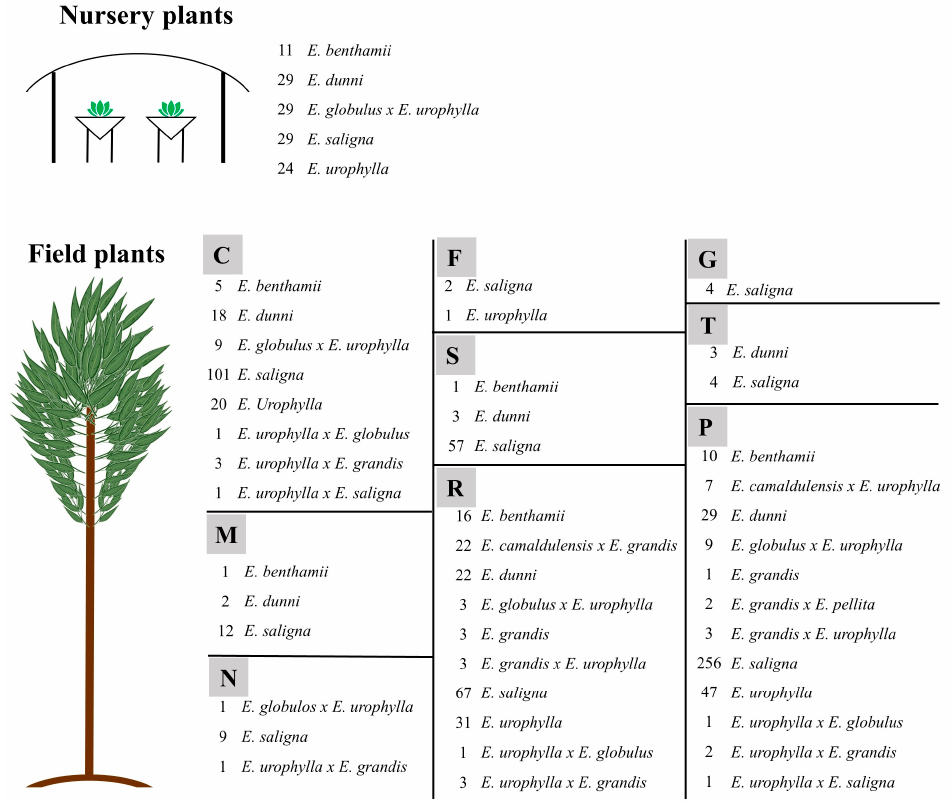
Figure 6. Overview of Eucalyptus spp. leaf collection and number of samples for each clone. C—Cambisol, F—Plintosol, G—Gleysol, M—Chernosol, N—Nitosol, P—Argisol, R—Neosol, S—Planosol, T—Luvosol.